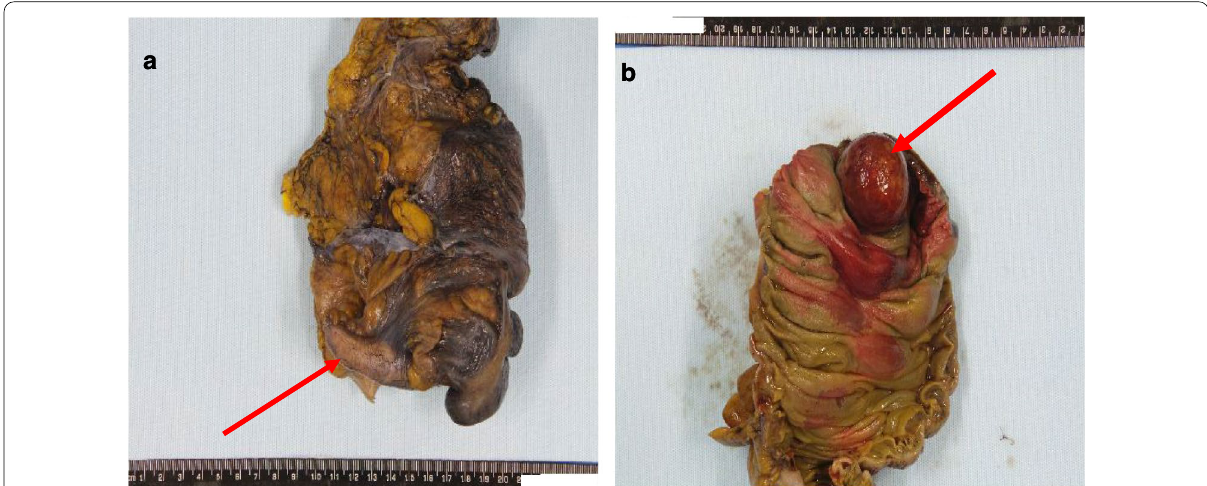
Fig. 3 Macroscopic images of resected specimens: a gross appendix externally at caecal pole, b extruding mass into caecal lumen from the appendix. Histopathological evaluation revealed ‘vermiform smooth appendix with a length of 8 cm and a diameter of 2 cm is present. An intraluminal cap of mucosa, 4 4 3 cm, is present at the base of the appendix and projects into the lumen of the caecum, 2 cm from the ileocaecal valve. Appendiceal × × lumen is smooth and contains thick mucus, no projections identified. Colonic mucosa has patchy areas of erosions.’